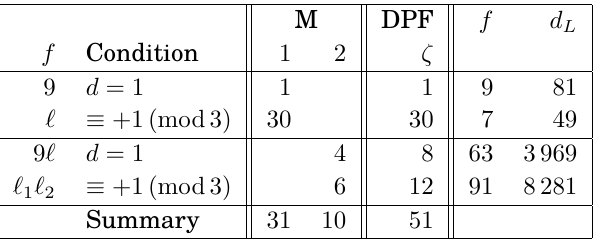
Table 2: Cyclic cubic discriminants d L = f 2 in the range 0 < d L < 10 5 .